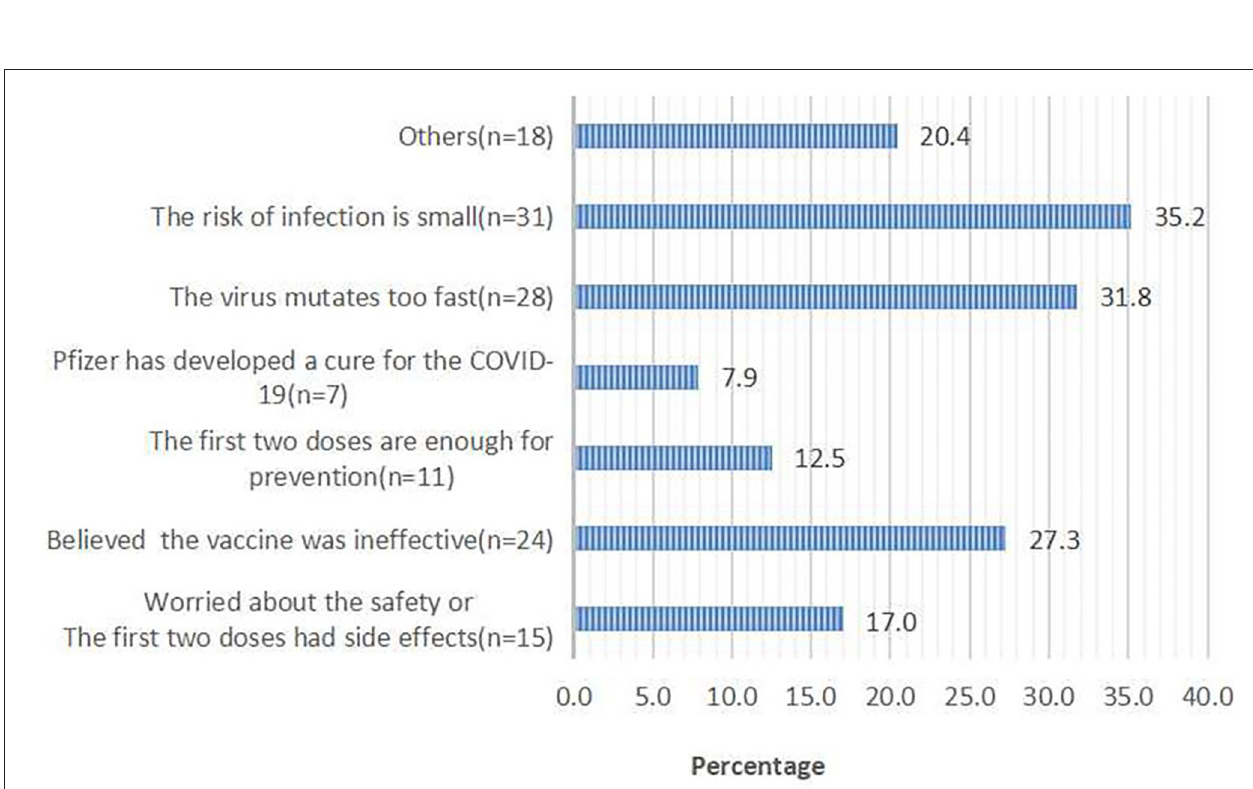
Frontiers in Public Health |